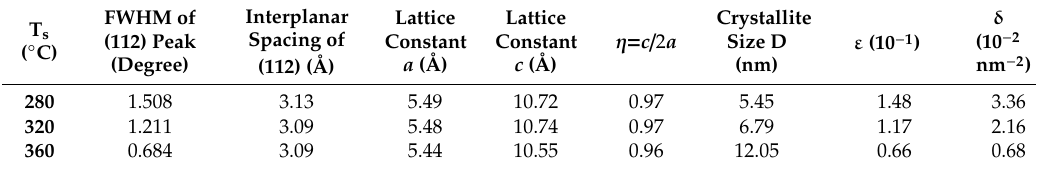
Table 1. Lattice constants of the CMTS thin films deposited at di ff erent substrate temperatures.